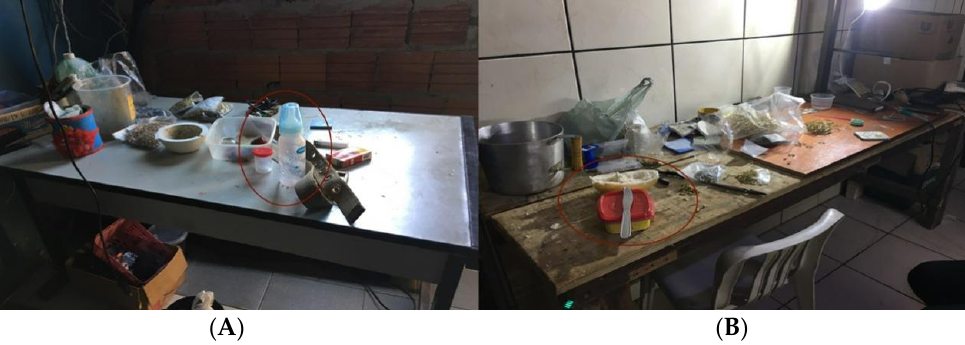
Figure 1. Welder ’ s workstations with baby feeding bottle ( A ) and food items ( B ). Limeira, 2019.